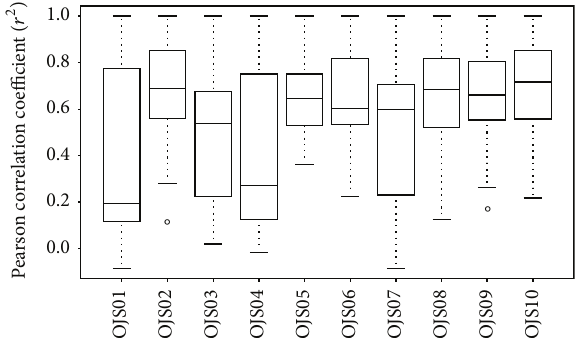
Figure 3: Pearson correlation coefficient ( 𝑟 2 ) between the OJS sam- ples. OJS01, Ojeok-san water extract from the laboratory; OJS02– OJS10, Ojeok-san granules from Korean